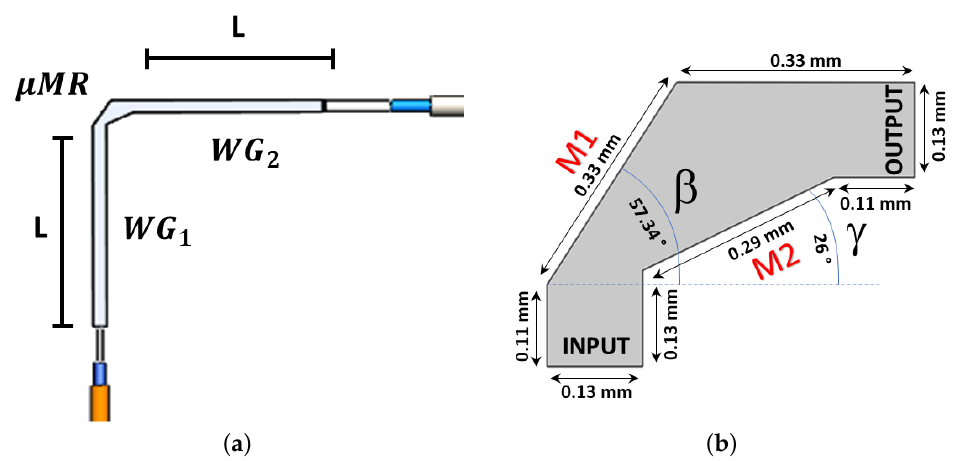
Figure 1. Design of the micro-splitter ( µ SPT ): ( a ) a micro-mirror ( µ MR ) in-between two micro- waveguides ( µ WGs ) of length L . ( b ) For L = 0 cm, the design of the µ SPT matches with that of the µ MR and consists of an input and output surface and two surfaces M 1 and M 2, respectively, tilted at the angles { β , γ } .